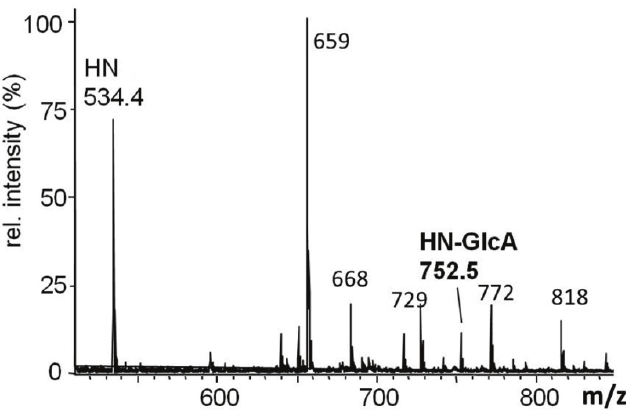
Figure 8. MALDI-MS spectrum of the permethylated O -glycan alditols derived by reductive β -elimination from hDG5 coexpressed with dGlcAT-P in CHO-Lec2 cells. An intense signal at m / z 752 (HN-GlcA + Na + ) revealed a glucuronylation of the T-antigen (HN + Na + ). Non-labeled signals in the mass range up to m / z 1000 are matrix-derived signals. Short notation of glycan structures: H, hexose; N, N -acetylhexosamine.